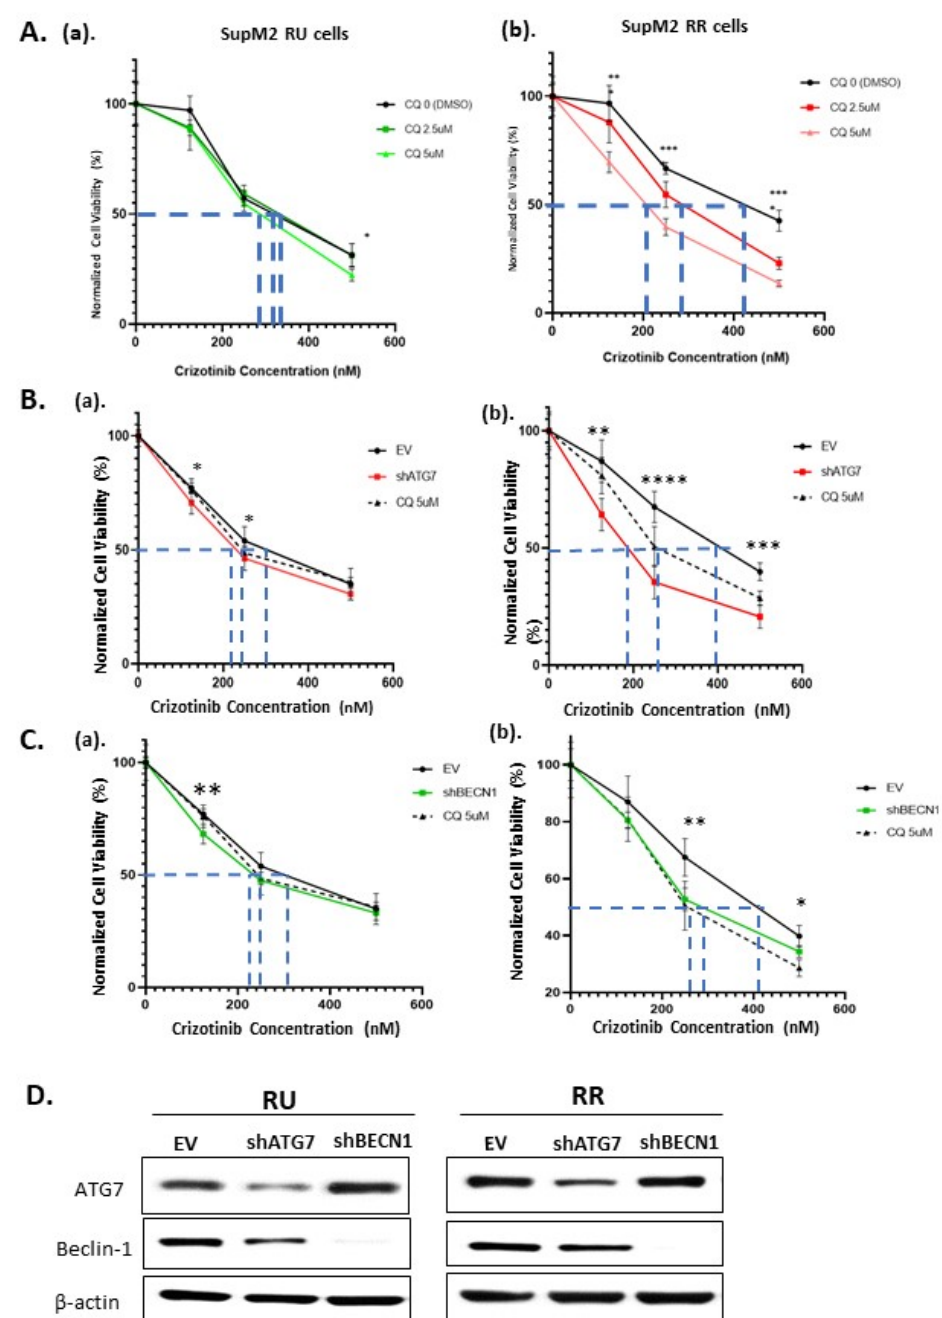
Figure 3. Inhibition of autophagy significantly enhanced the crizotinib-induced loss of cell viability in RR but not RU cells. ( A ) Cell viabilities of SupM2 RU and RR cells treated with different dosages of crizotinib (0, 125, 250, and 500 nM) and chloroquine (0, 2.5, 5 µ M). Cell viability was determined by Trypan Blue after 24 h. ( B ) SupM2 RU ( a ) and SupM2 RR ( b ) cells were treated with different dosages of crizotinib (0, 125, 250, 500 nM) for 24 h following knockdown of ATG7 or administration of 5 µ M chloroquine (positive control). ( C ) SupM2 RU ( a ) and SupM2 RR ( b ) cells were treated with different dosages of crizotinib (0, 125, 250, 500 nM) for 24 h following knockdown of Beclin-1 or administration of 5 µ M chloroquine (positive control). Original blots are shown in Figure S4. Data shown as mean ± standard deviation (SD), n = 3, * p < 0.05, ** p < 0.01, *** p < 0.001, **** p < 0.0001, Student’s t test. Three independent experiments were performed. ( D ) Western blots to assess the efficiency of shRNA knockdown of ATG7 or Beclin-1 in both cells. The most representative blot was